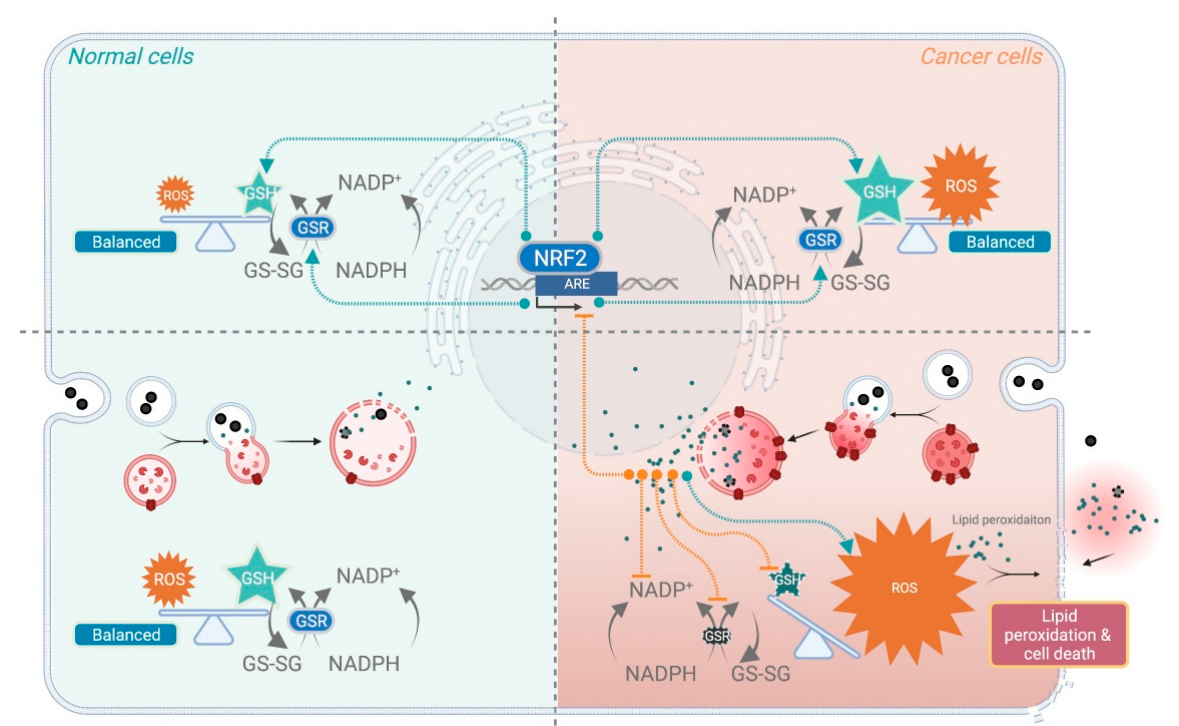
Figure 1. The mechanisms of ZVI-based NPs to selectively boost cancer cell death. Cancer cell specific induced cell death by ZVI-based NPs through shifting the balance between ROS and scavenging systems. Created with BioRender.